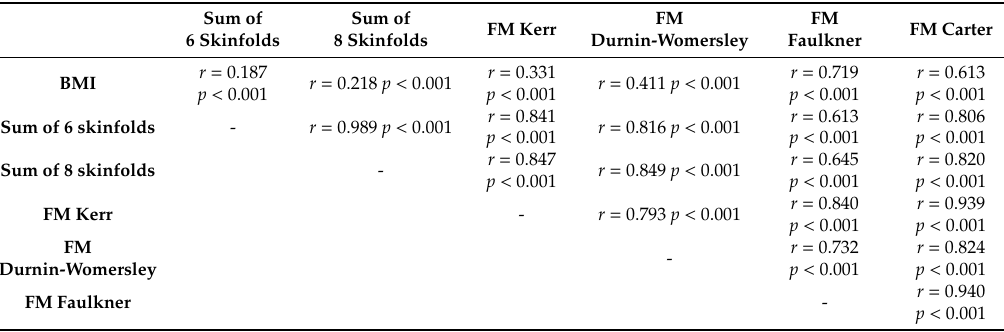
Table 4. Correlation between BMI; sums of skinfolds and fat